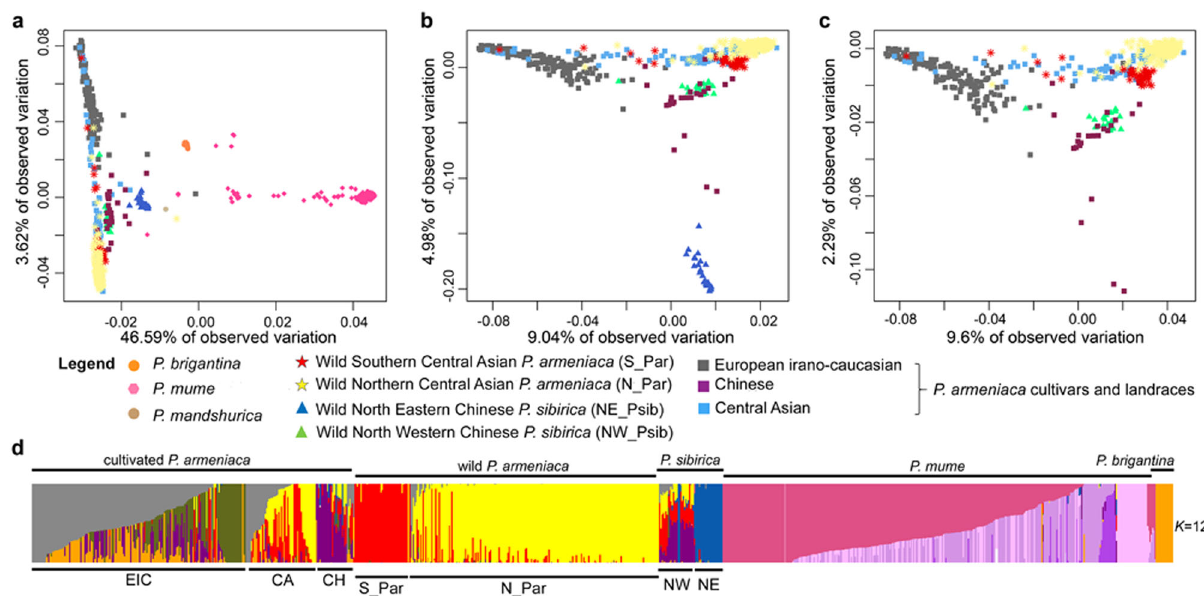
Fig. 4 Population structure and variation in Armeniaca wild and cultivated apricots. a Principal component analysis (PCA) from a set of 95,686 SNPs; the fi rst PCA component explained 46.59% of total variation, the second component only 3.62%. The colors and signs correspond to the ones depicted in Fig. 1a-b. b PCA after removal of P. mume , P. brigantina and P. mandshurica individuals. Orange circles: P. brigantina , pink circles: P. mume , beige circles: P. mandshurica ; rectangles: P. armeniaca cultivars and landraces (European in grey, Chinese in purple, Central Asian in blue); red stars: wild Southern Central Asian P. armeniaca (S_Par); yellow stars: wild Northern Central Asian P. armeniaca (N_Par); blue triangles: wild Northern Eastern Chinese P. sibirica (NE_Psib); green triangles: wild Western Chinese P. sibirica (NW_Psib). c PCA after removal of P. sibirica accessions from the NE_Psib populations. d fastSTRUCTURE barplot of the 917 Armeniaca individuals at K = 12 and 95,686 SNPs. EIC, European Irano Caucasian; CA, Central Asian; CH, Chinese; S_Par, Southern Central Asian P. armeniaca ; N_Par, Northern Central Asian P. armeniaca ; NW, North_Western P. sibirica ; NE, North_Eastern P. sibirica . Source data are provided as a Source Data fi